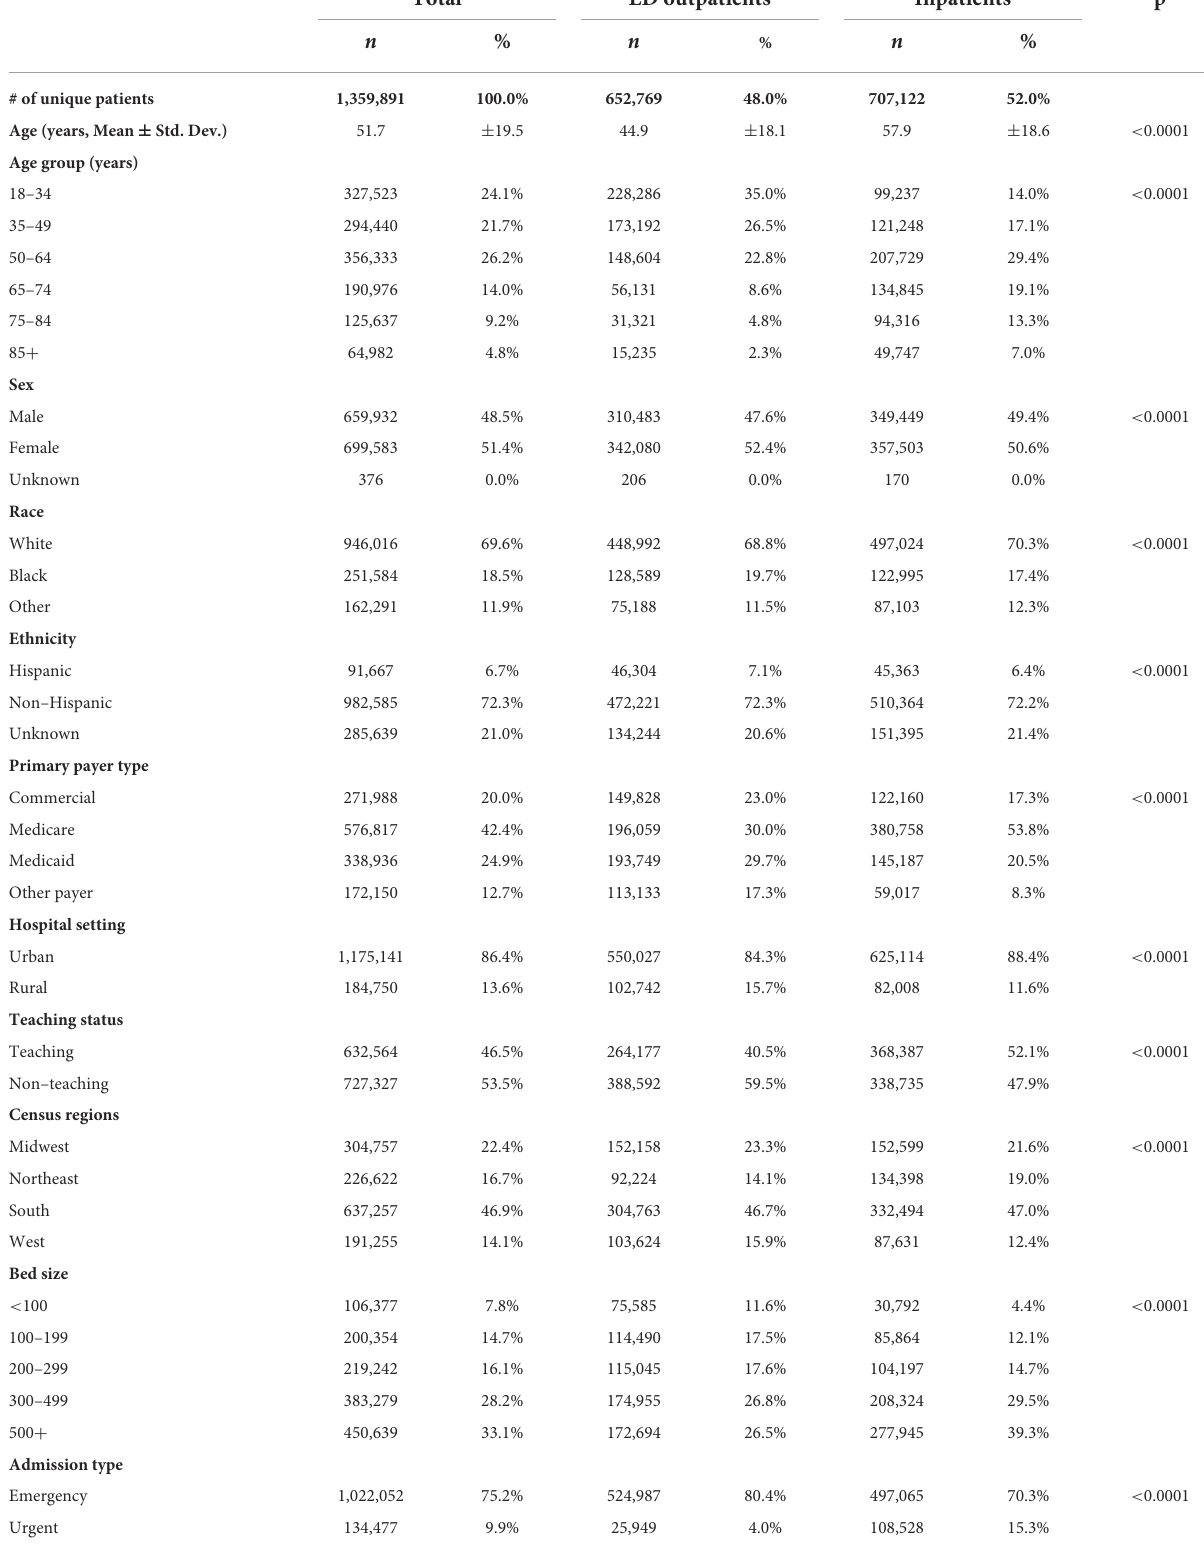
TABLE 1 Patient and hospital characteristics among patients with a seizure diagnosis during index hospital